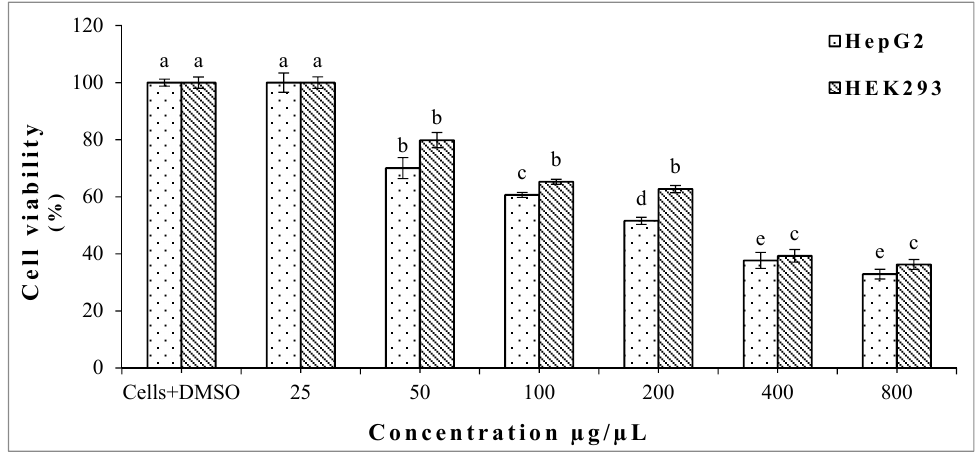
Figure 1. Viability percentage of HepG2 and HEK293 after treatment of crude oregano Essential Oils (EO). Bars with different letters for each cell line indicate mean values significantly different at p < 0.05 according to Tukey (B) test. Data are expressed as mean of three replicates ± SD.